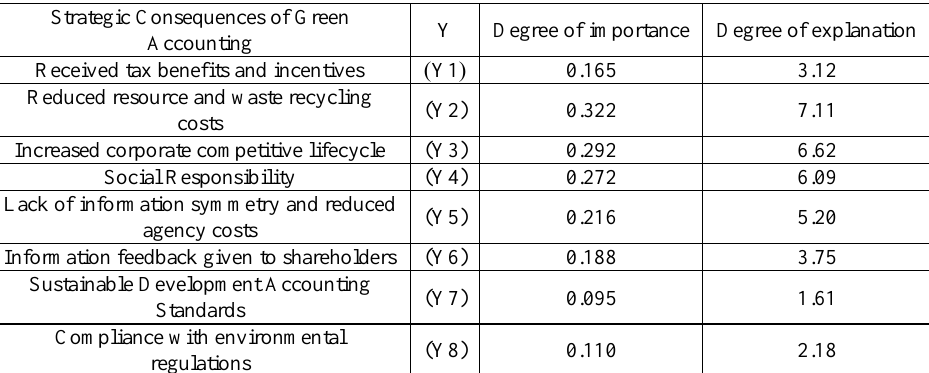
Table 11. Significance of each competition-level